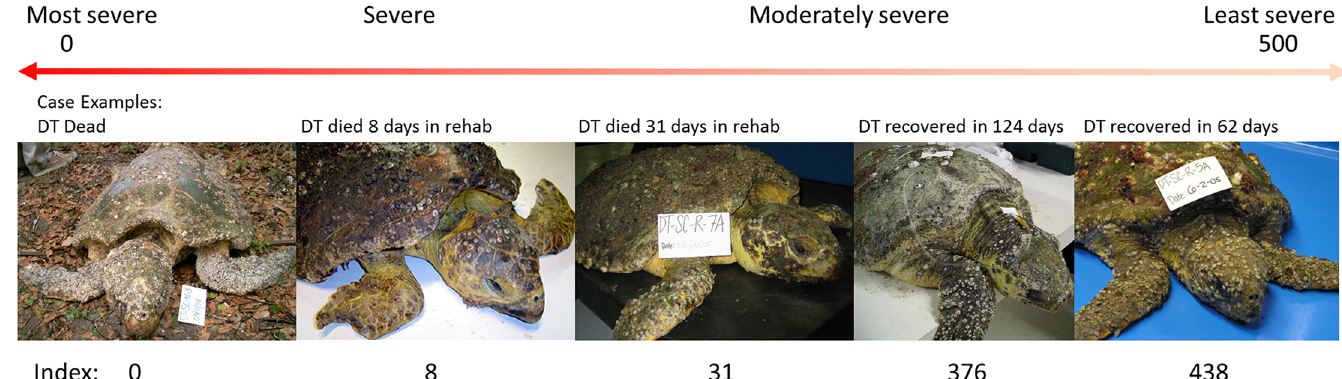
Fig 1. Diagram of severity indicator with five case examples of debilitated loggerhead sea turtles. Images show turtles at time of admission.